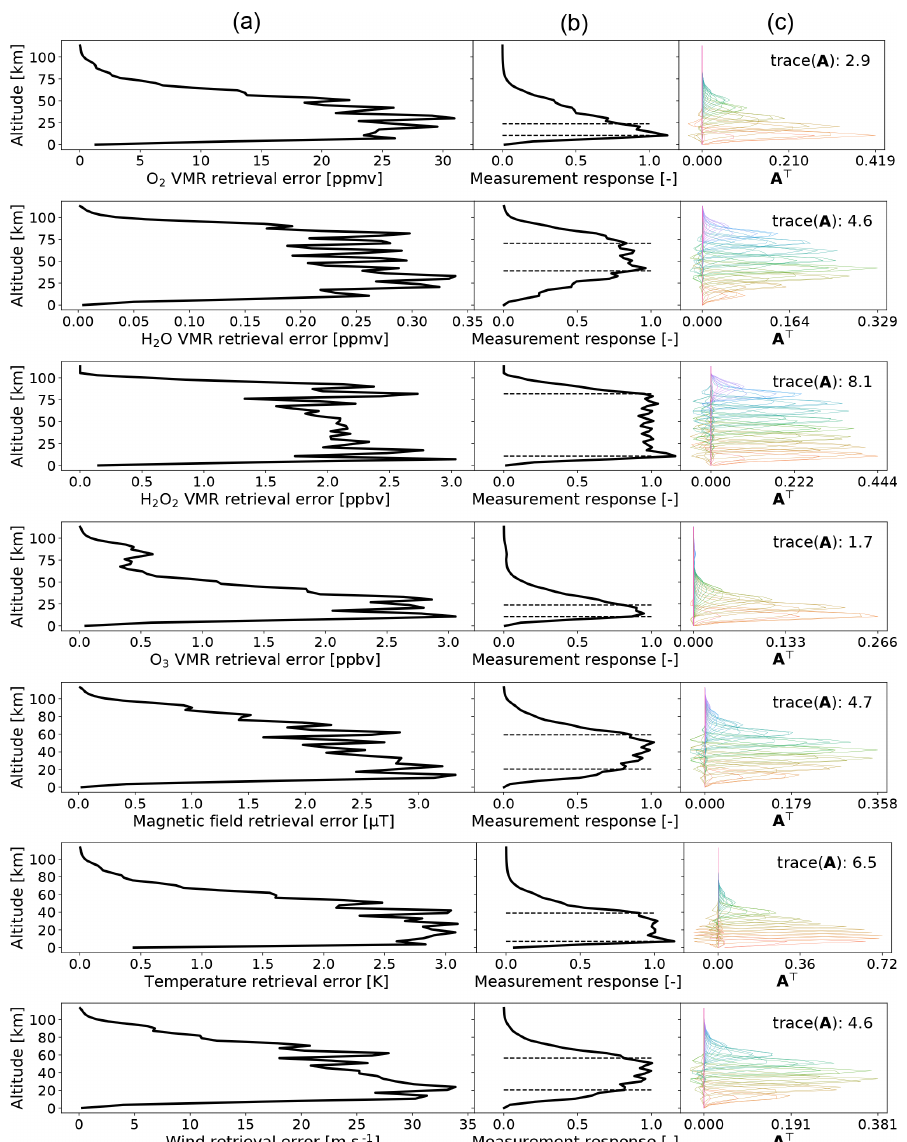
Figure 5. Forward model parameter error estimations for the atmosphere of Fig. 2 in limb-scanning mode with 1s integration time at each of the tangent altitudes of Fig. 4. By columns, column (a) shows the total error estimations and these errors, column (b) shows the measurement response by the solid line with the dashed lines marking the 0.8 level, column (c) shows the transpose of the averaging kernel, color coding its columns and showing its trace or the degrees of freedom of the setup. The rows show the forward model parameters whose retrieval are being simulated, with the top row showing molecular oxygen, the second row showing gaseous water, the third row showing hydrogen peroxide, the fourth row showing ozone, the fifth row showing magnetic field, the sixth row showing temperature, and the last row showing wind